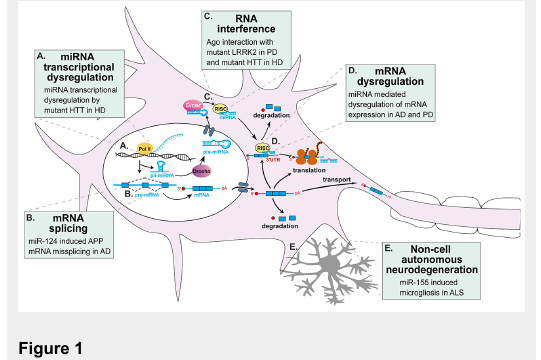
miRNA alternations in neurodegenerative diseases. Numerous alternations in miRNA biogenesis and function were found to contribute to the pathogenesis of several neurodegenerative diseases including: (A) In HD, miRNA transcription is disturbed as mutant huntingtin does not bind REST (which is normally bound to wild-type huntingtin), allowing the formation of NRSE thus repressing the transcription of neuronal miRNAs [135, 181, 183]. Mutant huntingtin also binds to p53 dysregulating p53-mediated transcription of miRNAs [16, 188]. (B) Downregulation of miR-124 has been found to cause missplicing of APP in AD [42]. (C)